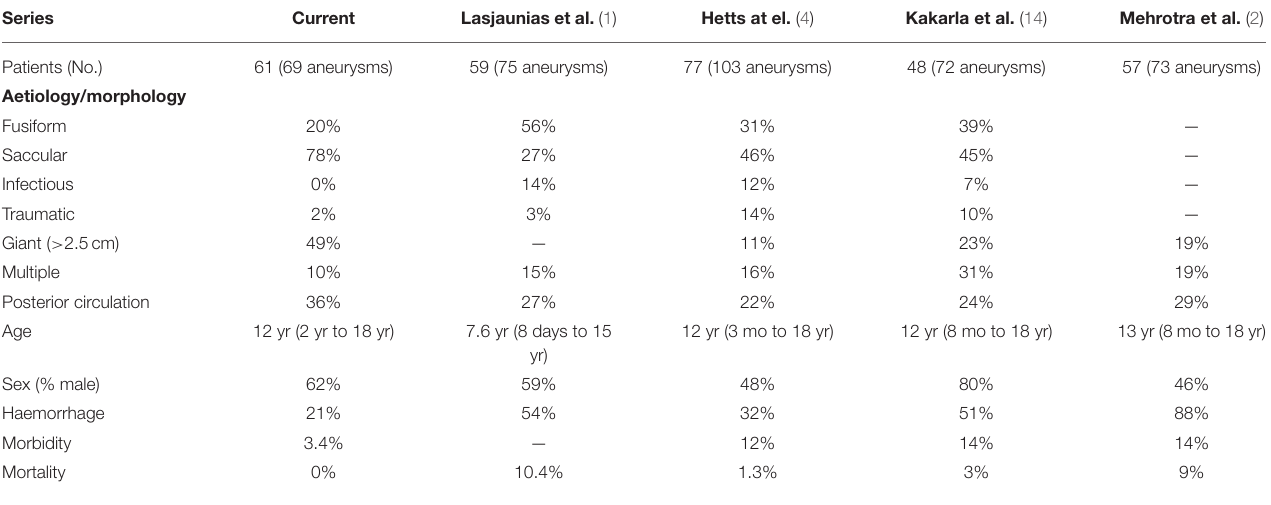
TABLE 5 | Aneurysm characteristics in various case series and meta-analyses.